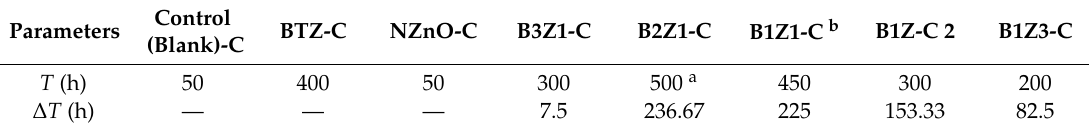
Table 2. T and ∆ T of free films determined from ∆ E * = 6 of underlying bamboo.